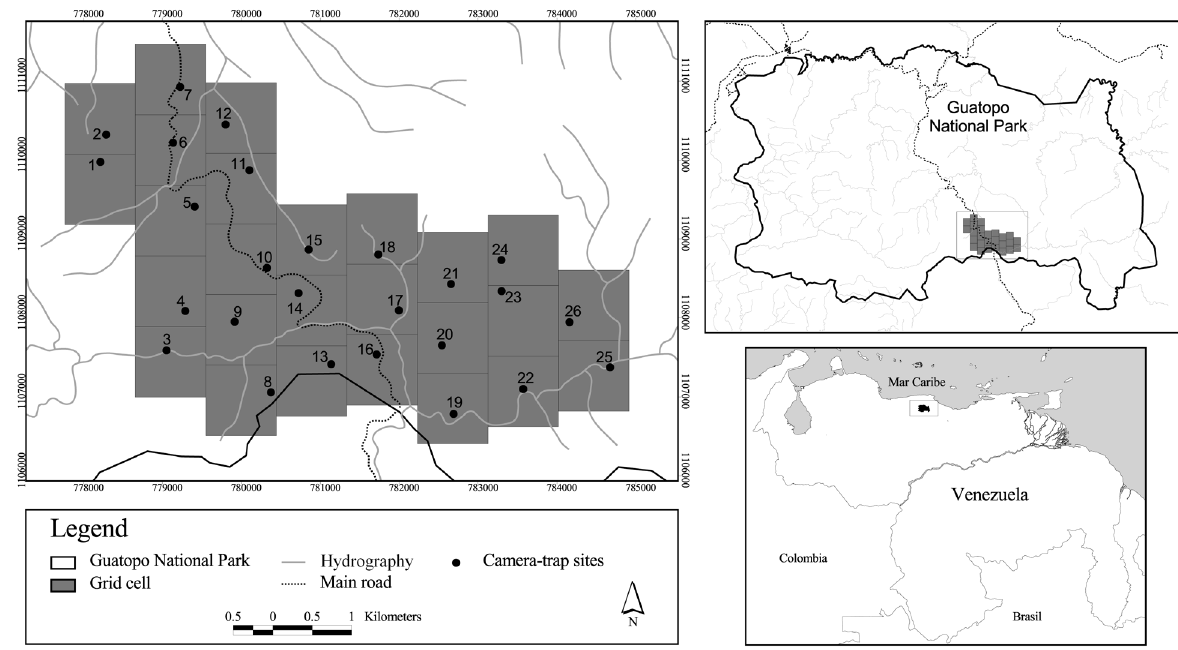
Figure 1. Location of Guatopo National Park in Venezuela and map of the 26 grid cells making up the total study area. Black dots show the location of the detection stations by